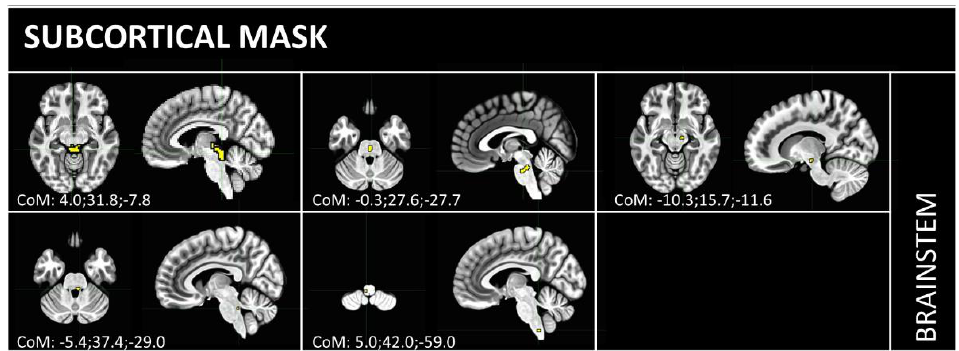
Figure 6. Clusters of supralinear activation for the 8 (0%) – 4 (3%) – 7 (7%) triplet extracted from the